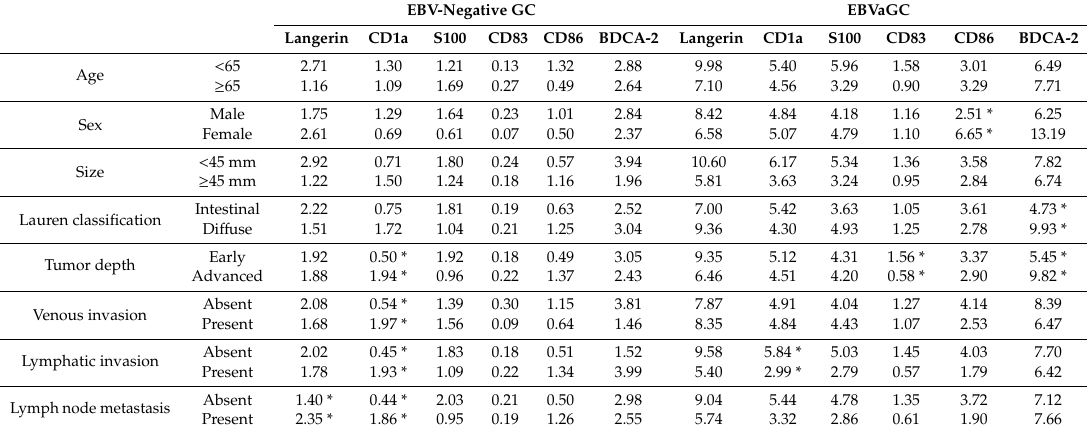
Figure 5. Number of dendritic cells that infiltrated gastric cancer tissue. Dendritic cells expressing each DC marker were counted, and the number per tumor area is shown. The number of DCs is significantly higher in EBVaGC than in EBV-negative gastric cancer for any of the DC markers ( p < 0.001 for Langerin, CD1a, CD83, CD86, and BDCA-2. p < 0.05 for S100, determined by using Wilcoxon rank sum test). Table4.